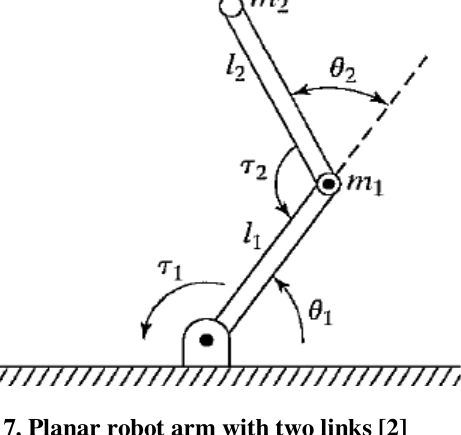
Fig. 7. Planar robot arm with two links [2]